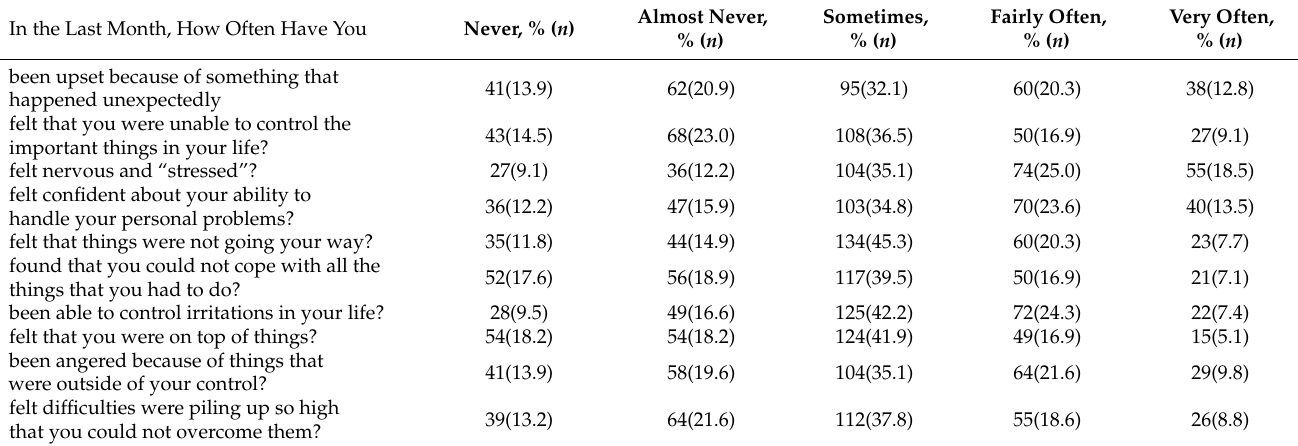
Table 5. Perception of stress descriptive statistics (frequency and percentage) ( n =